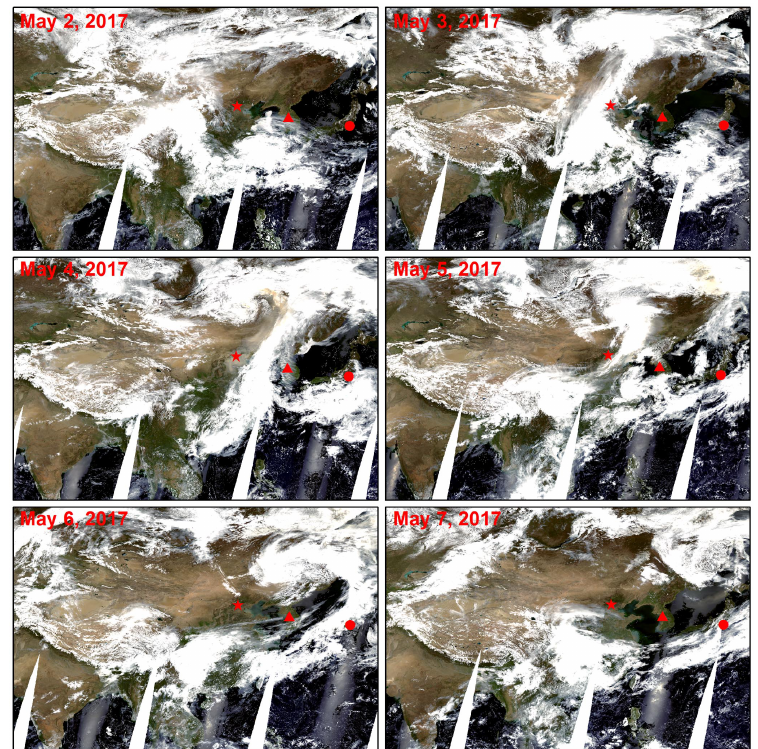
Figure 1. MODIS Terra images showing dust outbreak across East Asia from 2 to 7 May 2017. Red stars, rectangles, and circles indicate Beijing, Seoul, and Tokyo,